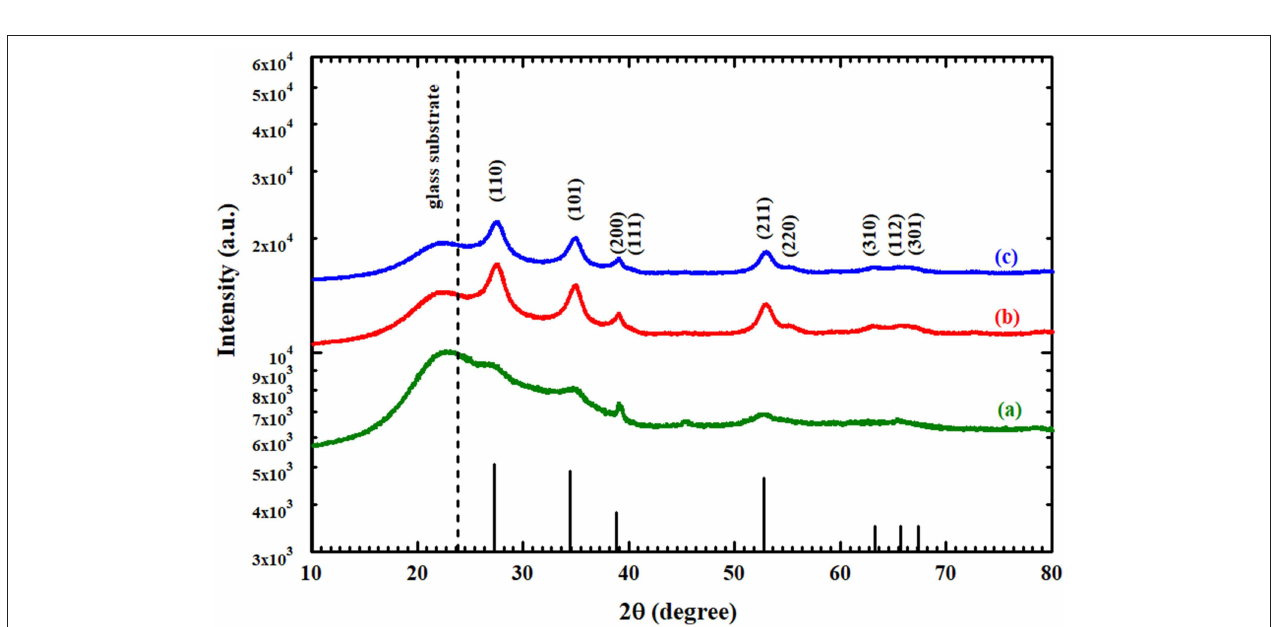
FIGURE 3 | XRD spectra of (a) as-deposited SnO 2 , (b) annealed SnO 2 , and (c) AgNPs/SnO 2 .